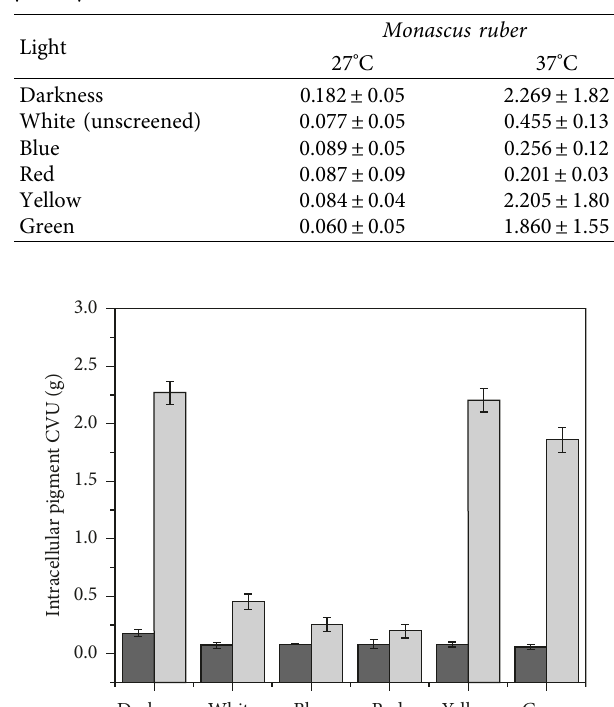
Figure 1: Effect of an altered light source on extracellular pigment yield by Monascus ruber at 27 ° C and 37 ° C. Table 2: Effect of an altered light source on intracellular pigment yield by Monascus ruber at 27 ° C and 37 °